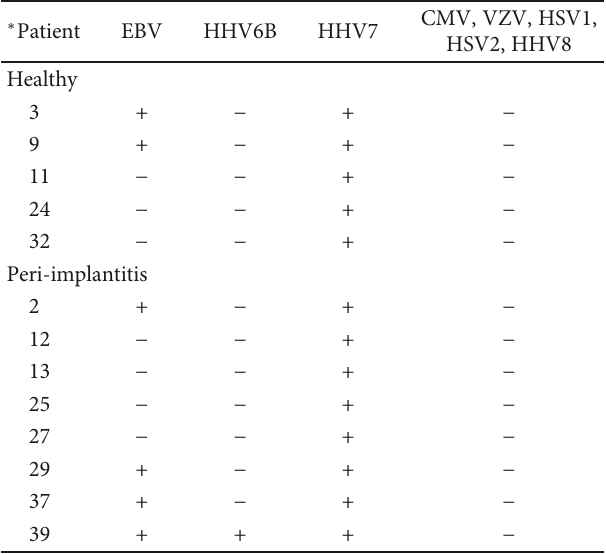
Table 2: Presence (+) or absence ( − ) of herpesviruses in saliva samples taken from the healthy and peri-implantitis groups. From the total, 16 healthy and 13 peri-implantitis patients are negative for all